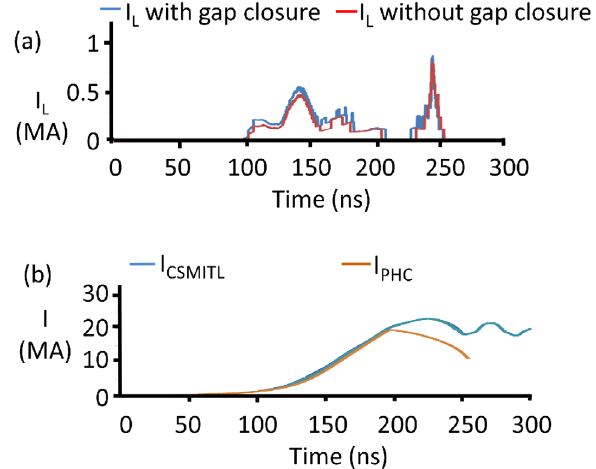
FIG. 7. The calculated temperatures of the anode surface at implosion time for the CSMITL are shown with and without gap FIG. 6. (a) Computed electron loss currents I between the L closure for the collisionless electron flow and without gap closure electron injector and the disk feed are shown for the cases with for collisional electron flow and with aluminum anodes and and without gap closure at 2 . 5 cm = μ s. Closure makes very little stainless steel anodes. The initial temperature of the anode surface difference in this design. (b) The calculated load currents with the was 21 °C. However, the 1D Screamer simulations do not treat the CSMITL and with the standard four-level MITL PHC for this enhanced losses at the edges and resistive heating, which are very stressing high-impedance load with gap closure are shown discussed in Sec. for comparison.